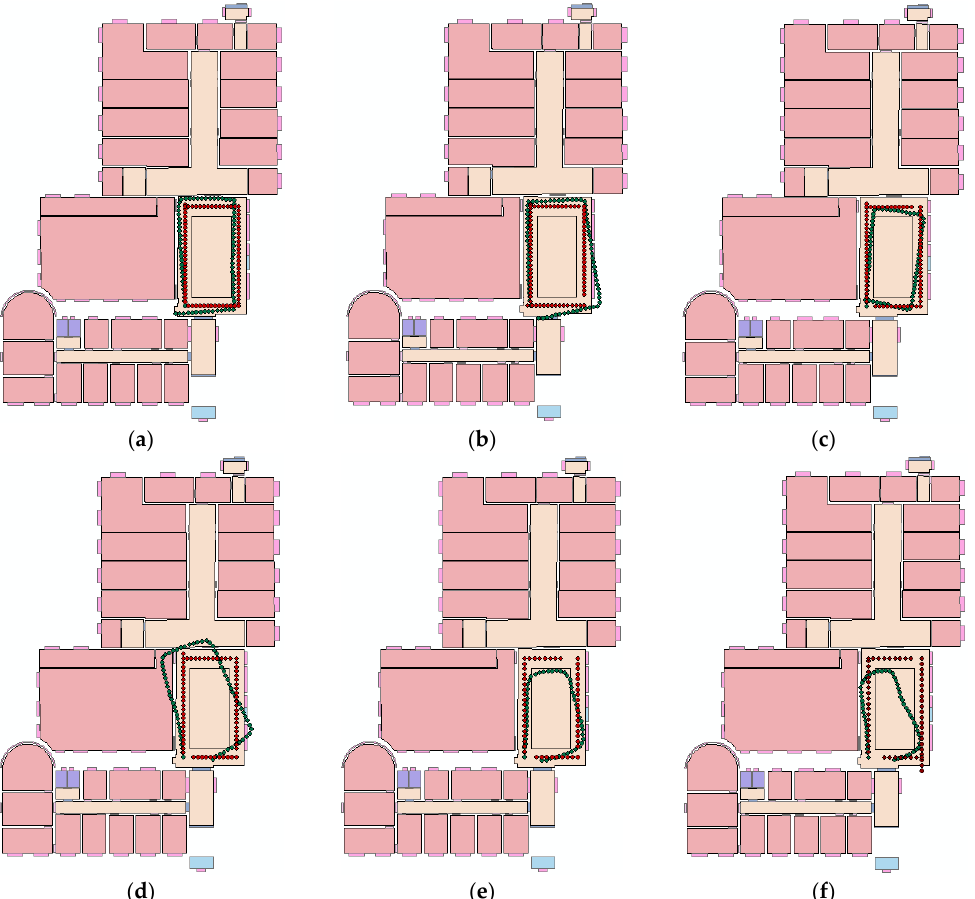
Figure 12. Heading estimation of six participants. The first column is the heading change relative to the last time stamp. The second column is the heading change relative to the start orientation. The third column is the third turn. ( a ) F1(Zhu); ( b ) F2(Zhou); ( c ) M1(Guo); ( d ) M2(Ma); ( e ) M3(Liu); ( f ) M4(He).